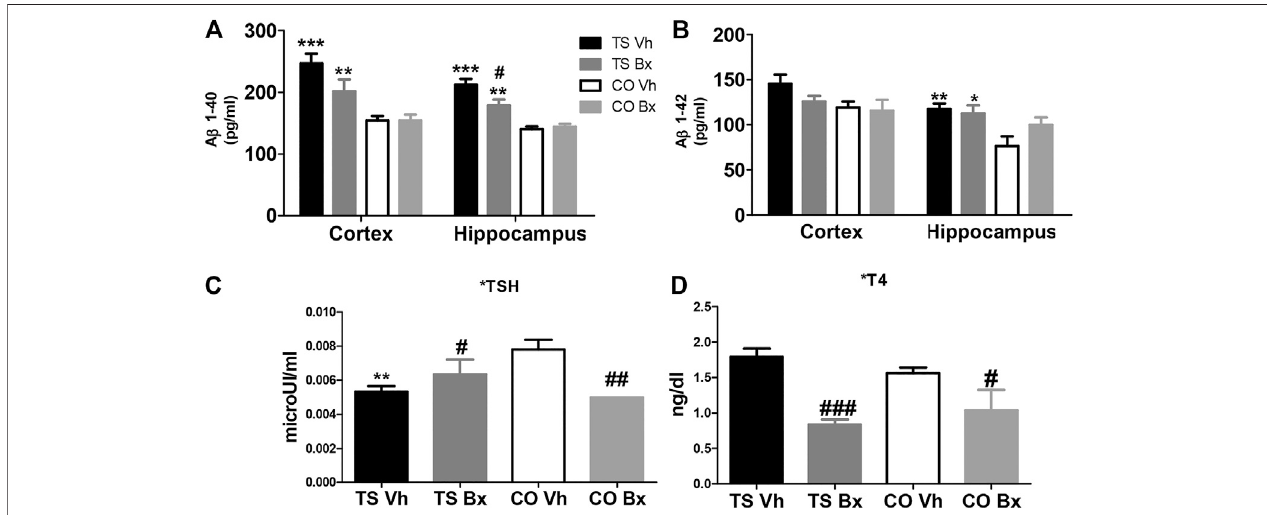
FIGURE 5 | Means ± S.E.M. of the levels of A β 1-40 (A) , and A β 1-42 (B) in the cortices and hippocampi of TS and CO mice under bexarotene or vehicle treatment and ofthelevels ofTSH (C) , and T4 (D) in the four groups ofmice.*: p < 0.05, **: p < 0.01; ***: p < 0.001TS Vhvs. COVh, or TSBxvs. COBx; #: p < 0.05; ##: p < 0.01; ###: p < 0.001 TS Bx vs. TS Vh, or CO Bx vs. CO Vh. Fisher ’ s LSD post-hoc